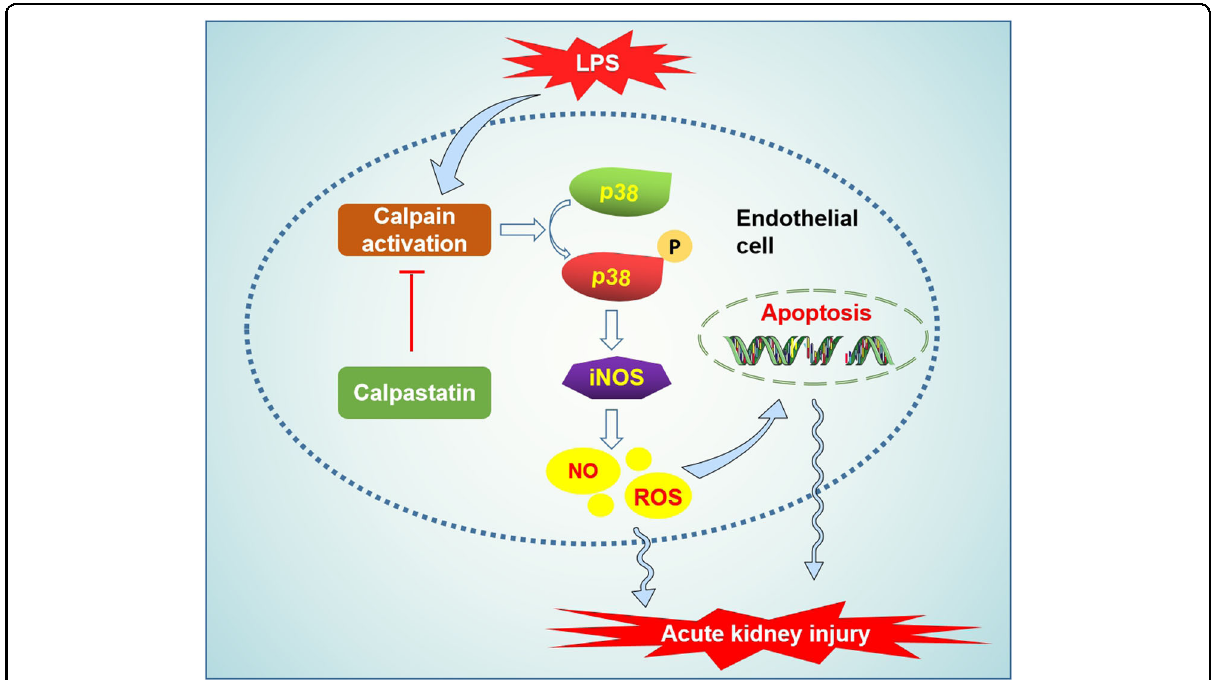
Fig. 6 Schematic showing the signaling pathway involved in LPS-induced AKI in endotoxemic mice. LPS activates p38 MAPK via calpain activation, which increases endothelial iNOS expression and NO/ROS production, which in turn leads to endothelial apoptosis through the caspase 3 pathway, thus inducing AKI in endotoxemic